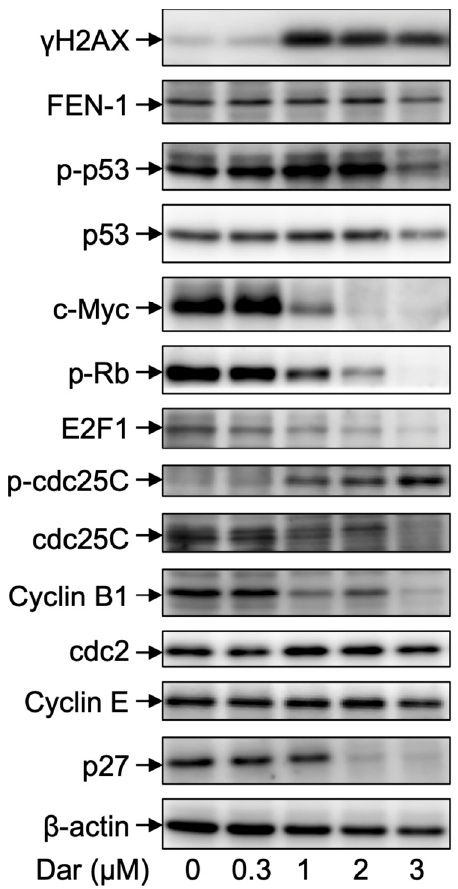
Figure 7. Expression profile of cell cycle arrest-related proteins in NB4 cells treated with darinaparsin. Following treatment with various concentrations of darinaparsin (0.3, 1, 2 and 3 µ M) for 24 h, the expression profiles of cell cycle arrest-related proteins were analyzed using Western blotting. Representative image of the expression profile of each key gene protein is shown from three independent experiments. Dar, darinaparsin; p-p53, phosphorylated p53; p-Rb, phosphorylated Rb; p-cdc25C, phosphorylated cdc25C. The images of beta-actin are identical to those in Figure 3D because the same experiment samples were used for